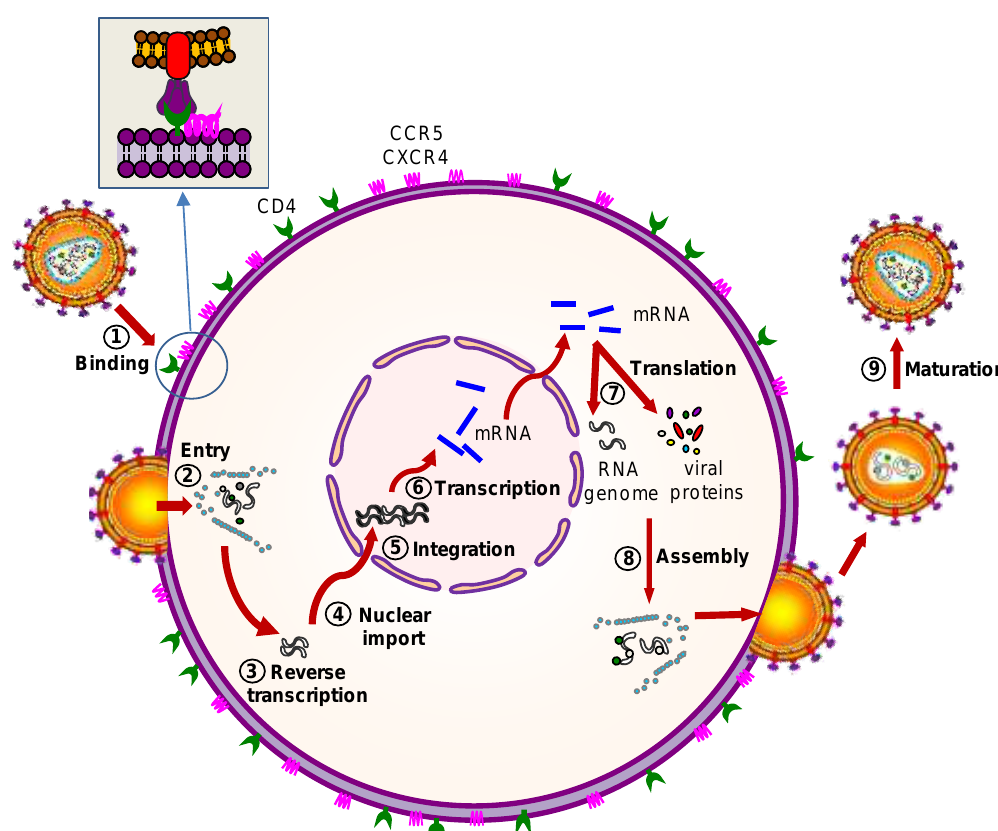
Figure 2. Steps of the HIV-1 replication cycle that can be targeted by gene therapy. The HIV-1 replication steps that can be targeted by gene therapy are shown: ( 1 ) HIV-1 binding to cell membrane; ( 2 ) HIV-1 entry into the cell; ( 3 ) reverse transcription; ( 4 ) transport of the HIV-1 proviral genome into the nucleus; ( 5 ) integration of the viral genome into the cellular DNA; ( 6 ) transcription of the HIV-1 proviral genome; ( 7 ) translation of the viral messenger RNA (mRNA) into new viral proteins; ( 8 ) virion assembly inside the cell; and ( 9 ) maturation of the immature virion into a completely infectious particle.